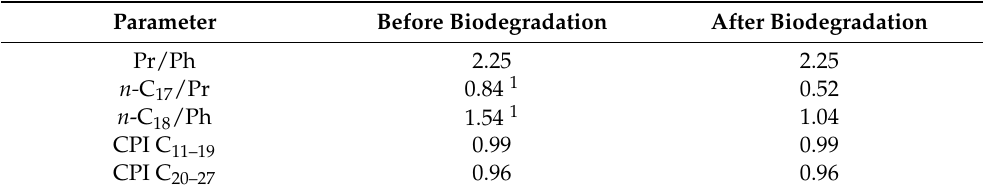
Table 1. Pr/Ph ratio, n- C 17 /Pr, n -C 18 /Ph, and carbon preference index (CPI) on crude oil before and after biodegradation.